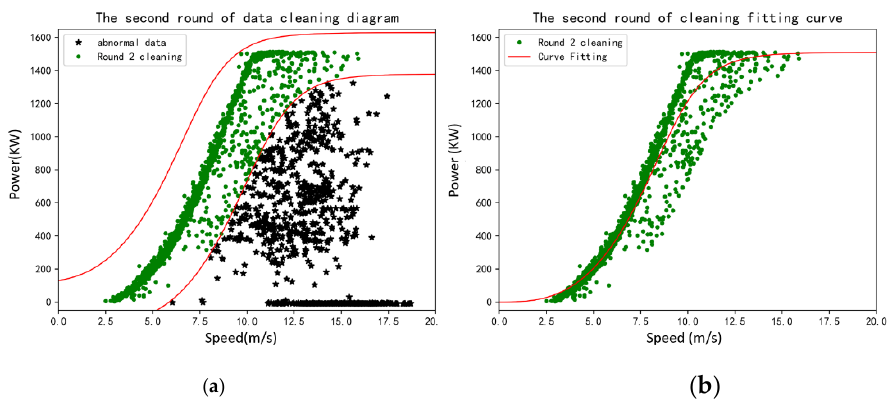
Figure 9. Same as Figure 8, but for the second round of data cleaning and power curve fitting. ( a ) The second round of data cleaning diagram; ( b ) the second round of cleaning fitting curve. The red lines in ( a ) enclose the area in which the wind speeds of the data samples deviate from the power curve obtained in Figure 8b by less than 2 m/s. The red lines in ( b ) are the refined power curve.